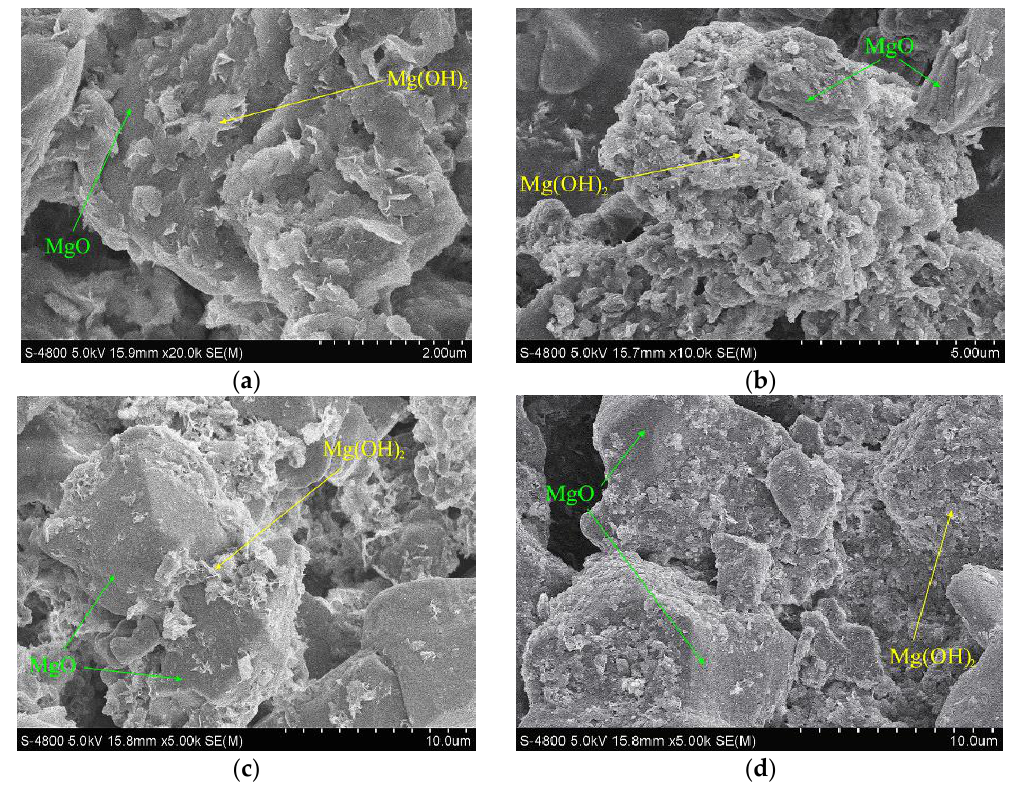
Figure 4. SEM images of hydration products: ( a ) Δn Cl− = 21.5 mol/kg, t = 10 min; ( b ) Δn Cl− = 21.5 mol/kg, t = 40 min; ( c ) Δn Cl− = 7.5 mol/kg, t = 10 min; ( d ) Δn Cl− = 7.5 mol/kg, t = 40 min.